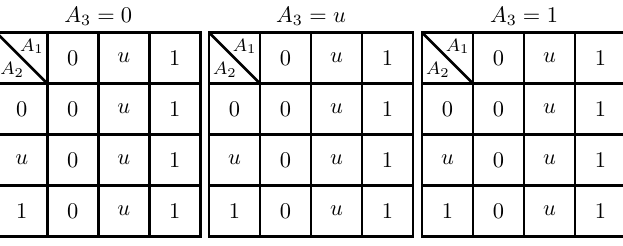
Figure 5. Three-variable relationships for f U